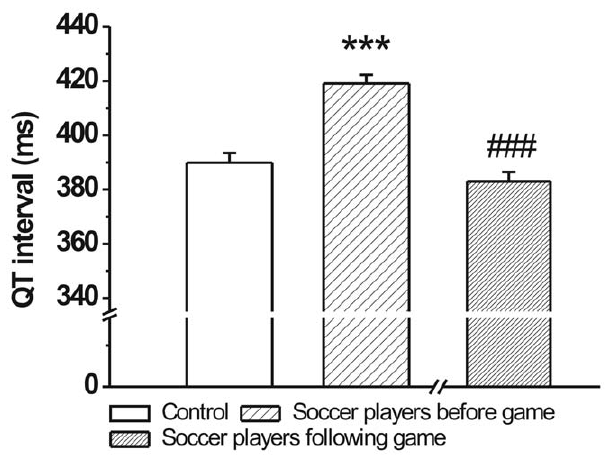
Figure 2. The QT intervals of age-matched controls and professional soccer players before and following a competitive game. The QT interval was significantly longer in soccer players before the game (n=76 persons/group; ***p , 0.001 vs. age-matched control; Means 6 S.E.M.; ### p , 0.001 vs. before game values).